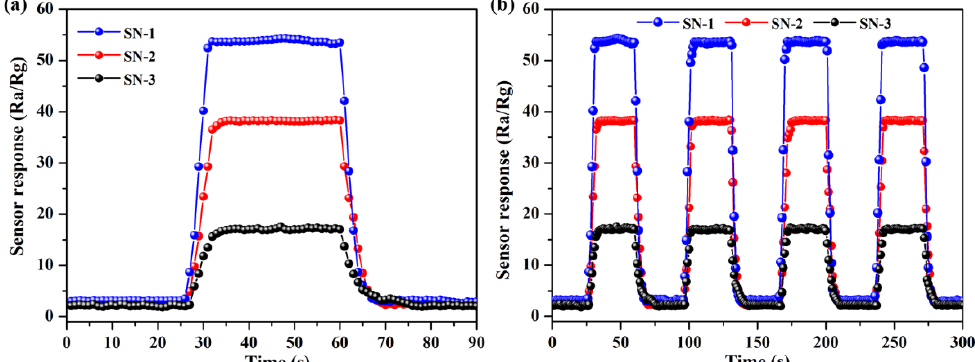
Figure 6. ( a ) Dynamic response and recovery curves of three SnO 2 samples relative to 50 ppm HCHO at 275 °C. ( b ) The repeatability of three sensors towards 50 ppm HCHO at 275 °C.